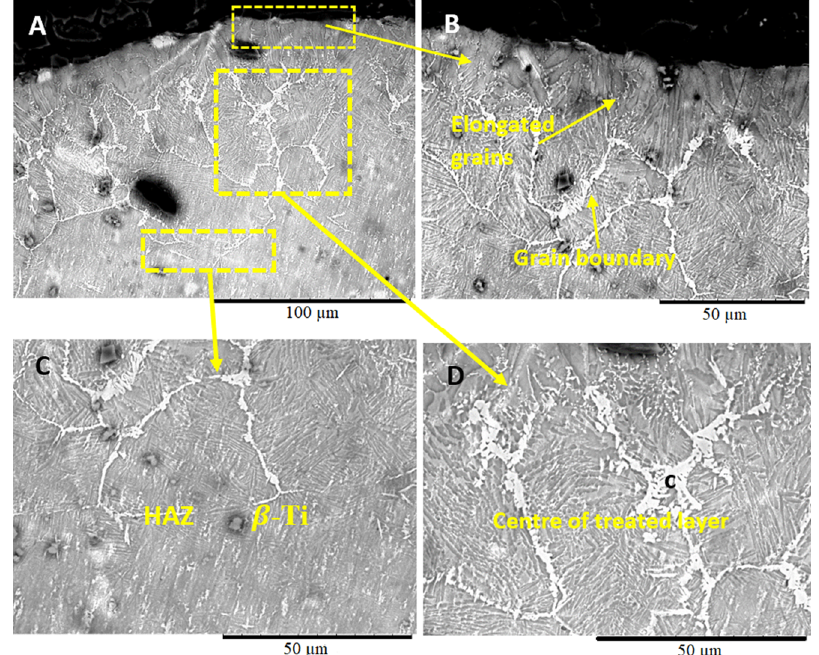
Figure 3. SEM micrographs of Ti-6Al-4V sample coated with Ni / Al 2 O 3 and surface melted welding current of 50 A. ( B ) Microstructure of the upper section of the treated layer, ( C ) microstructure at the middle of the treated layer and ( D ) microstructure at the HAZ.